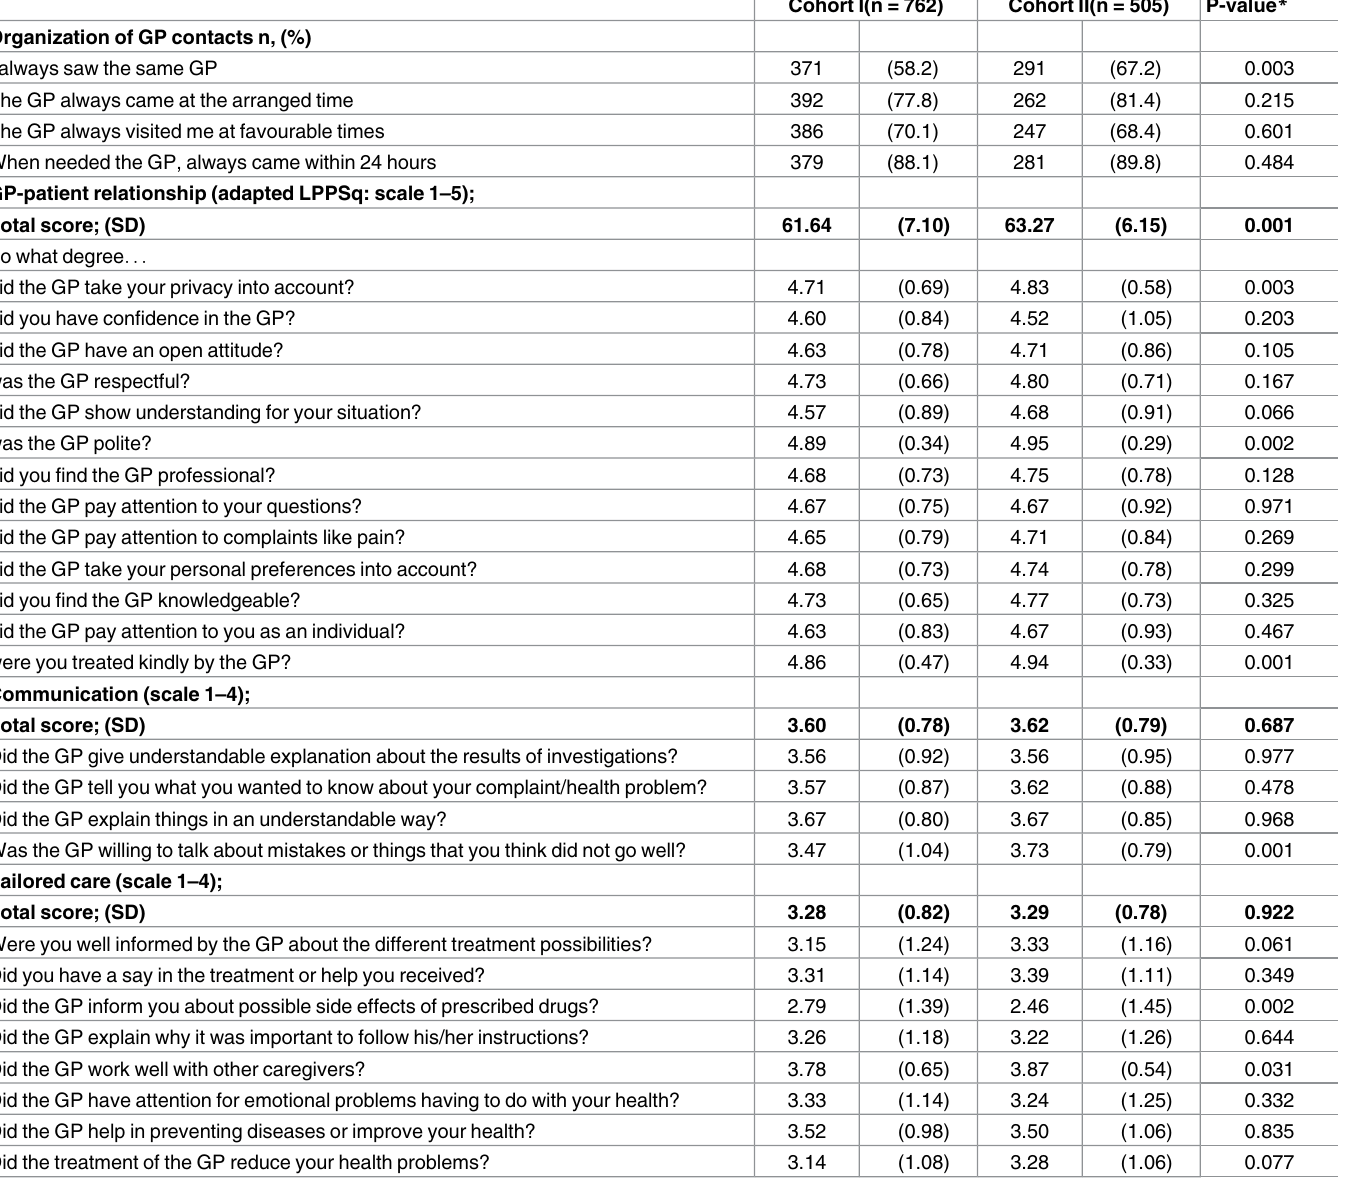
Table 3. Satisfaction about specific aspects of integrated care in GP care in older